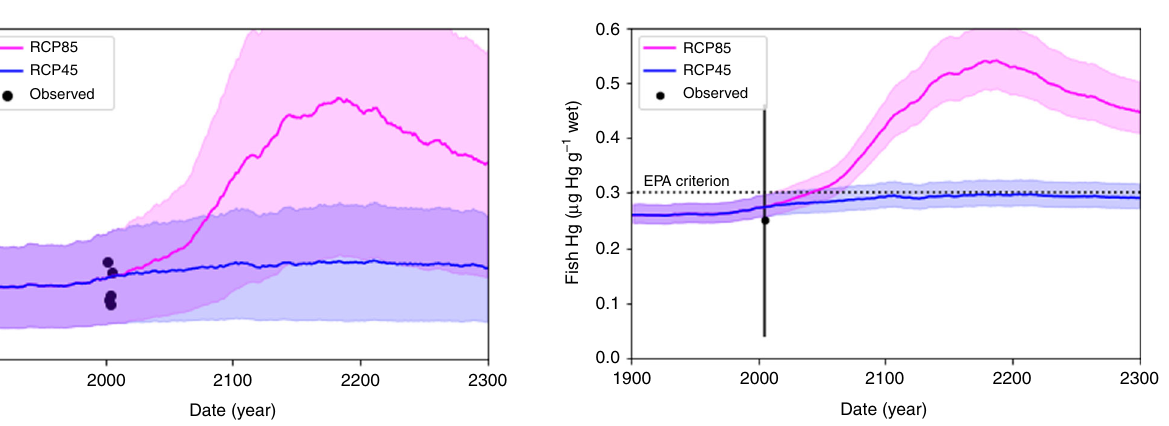
Fig. 4 Mercury cation (Hg II ) export for the Yukon River Basin (YRB). The annual riverine Hg II export is the sum of Hg II export across the YRB outlined in Fig. 3. The shaded areas represent uncertainty and the black dots indicate observed riverine export 16 .